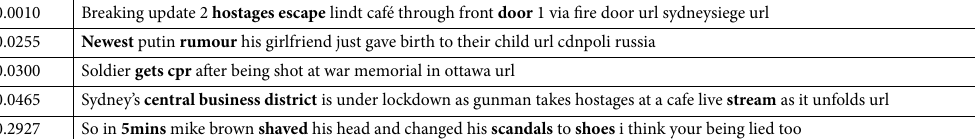
Table 4. Examples of D explain predicting suspicious words in rumors (marked in bold). D classify outputs probabilities in range [0, 1], where 0 and 1 represent rumor and non-rumor, respectively.